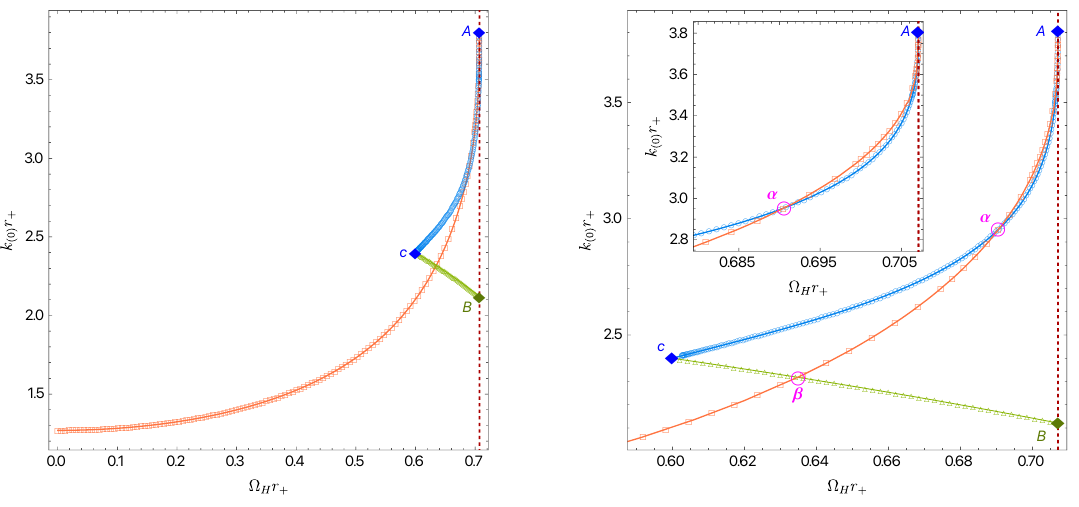
Figure 1 . Superradiant instability (for azimuthal number m = 2 ) and Gregory-Laflamme instability of Myers-Perry black strings with parameters e k , e Ω H . Superradiant instability occurs inside the (0) triangular region ABc , and Gregory-Laflamme instability occurs below the curve marked by orange squares. The Gregory-Laflamme onset curve intersects with the edge of the unstable superradiant √ region at points α and β . The vertical dashed line at e Ω H = 1 / 2 is